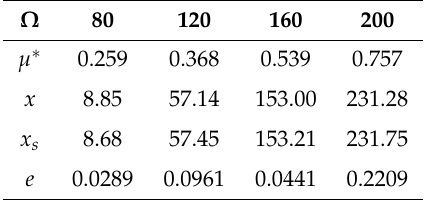
Table 2. The summary of the experimental results in Section